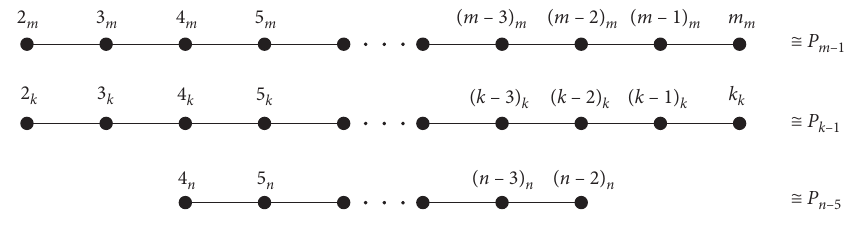
Figure 11: C ( m,k, n ) − N [ 2